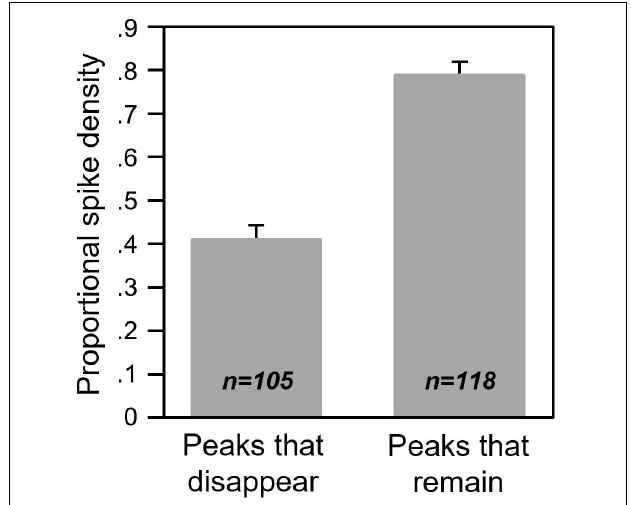
FIGURE 9 | Proportional spike densities for response features that disappeared or remained during iontophoresis of 8-OH-DPAT. The peak spike densities of response features were normalized to the largest response feature in their respective spike